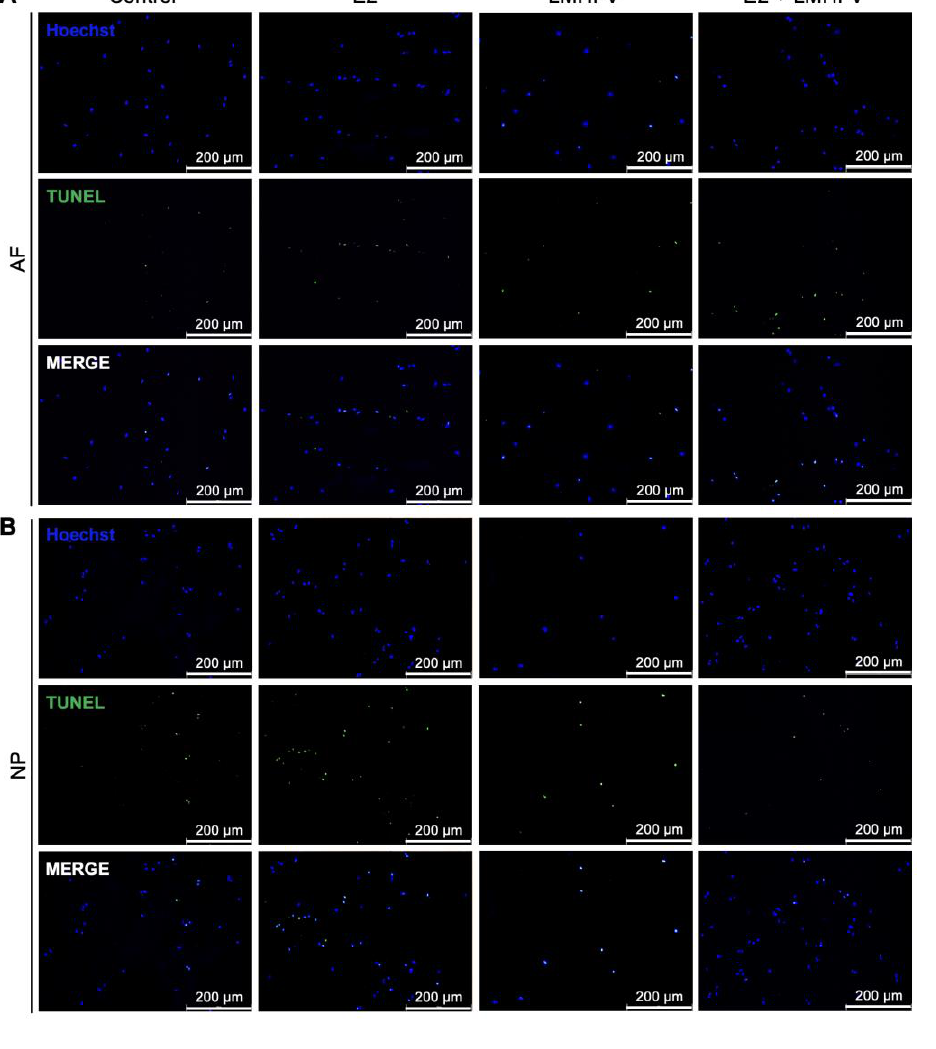
Figure A3. Amount of DNA normalised to wet weight (μg/g) in fresh AF and NP tissues and in samples from the control group after 21 days of organ culture. Results are presented in box plots ( n = 6 IVDs/group). * p < 0.05, *** p < 0.001.